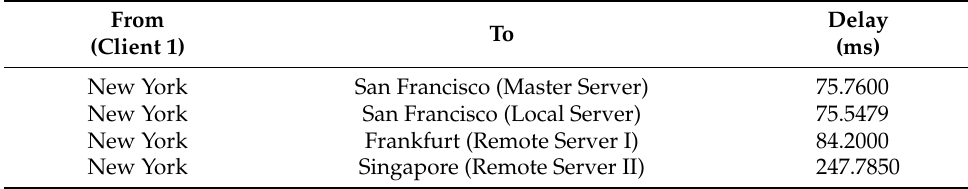
Table 12. Delay times between Client 1 and servers.